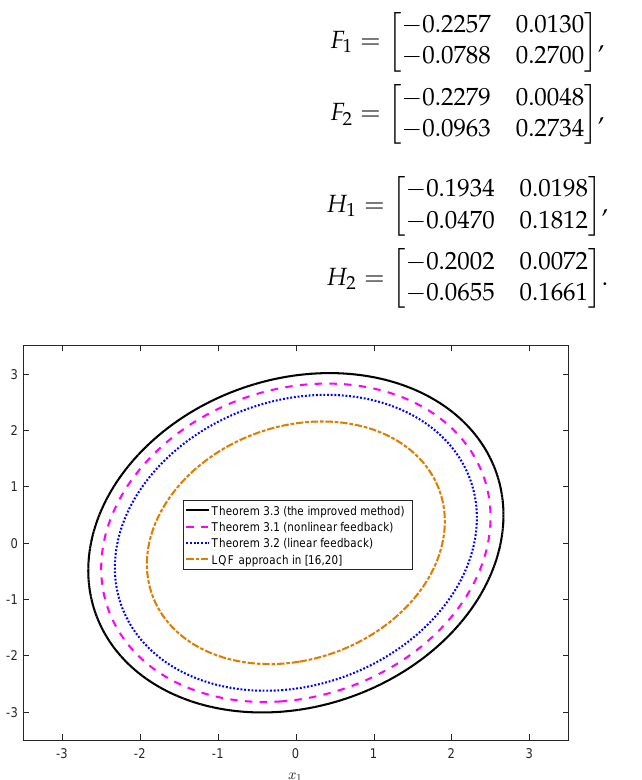
Figure 2. The invariant sets of the CLQF (derived by Theorems 1–3) and the LQF (derived by the method in